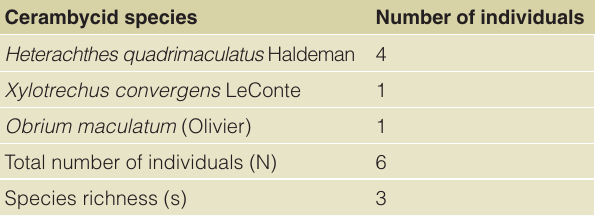
Table 8. Cerambycid (Coleoptera: Cerambycidae) Species Captured in BGSU-ENVS Woods, 2008 (Central Wood County, OH). Total number of individuals of each species caught during the entire trapping period (early June to early October). Traps were positioned in the approximate center of each forest and all checked each week.